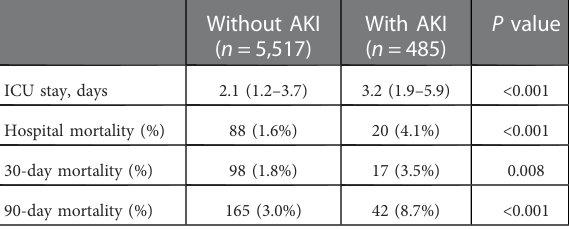
TABLE 2 Outcomes of cardiac surgery patients with or without